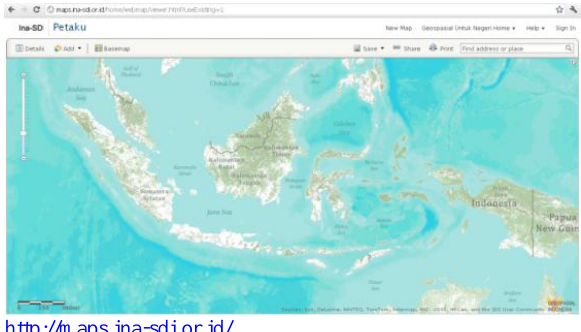
Figure 6. Geospasial Untuk Negeri (Indonesian Geoportal)